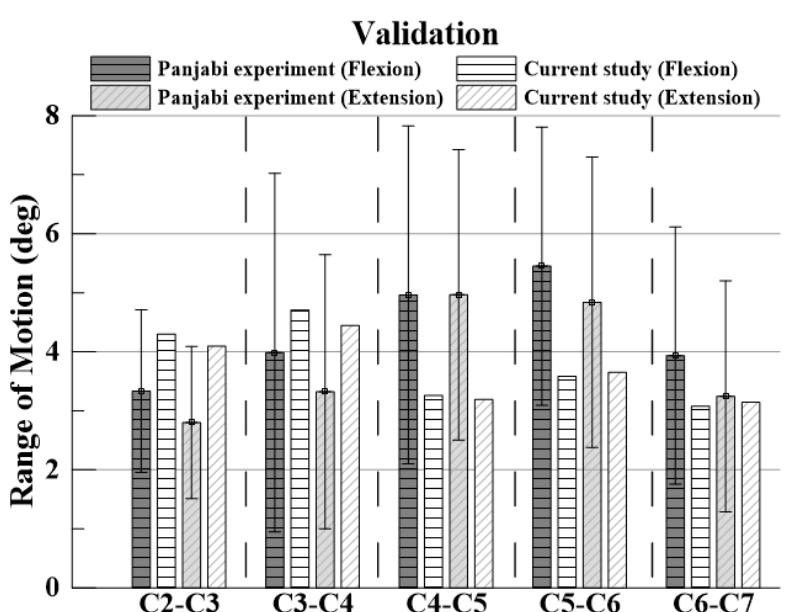
Figure 4. Finite element model: ( a ) flexion; and ( b ) extension.